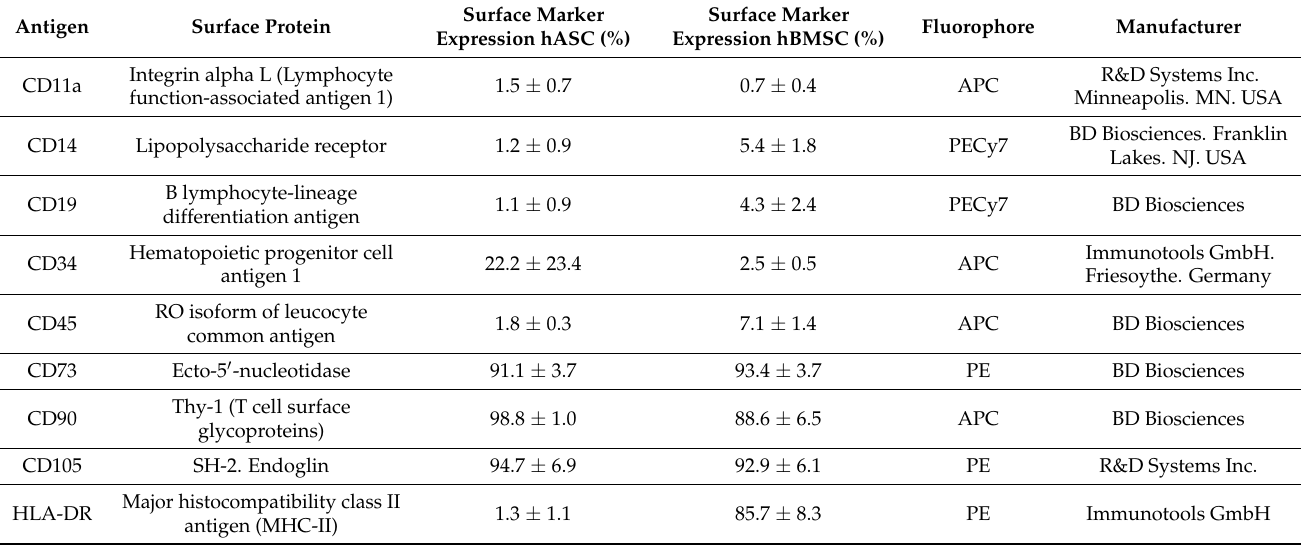
Table 3. Surface protein expression of hASCs and